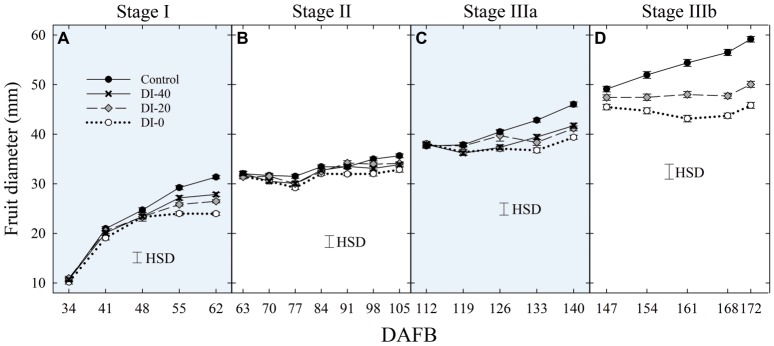
Fruit diameter at stage I (A), II (B), IIIa (C), and IIIb (D) of ‘September Bright’ nectarine fruit growth. Measurements done with a fruit caliper on trees irrigated to 100% (control), 40% (DI-40), 20% (DI-20), and 0% (DI-0) of crop evapotranspiration. Timeline expressed in days after full bloom (DAFB). Error bars represent standard errors of means (n = 36). Significant differences determined with analysis of variance and Tukey’s honestly significant difference (HSD, p < 0.05).